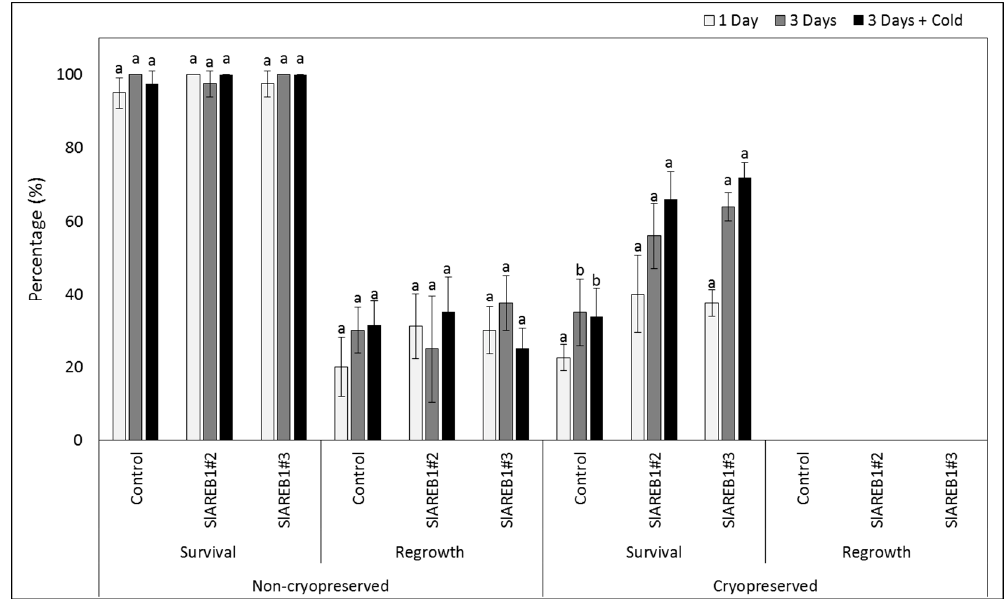
Figure 6. Survival and regrowth percentages of V-cryoplates treated non-cryopreserved and cryopreserved shoots tips of negative control, SlAREB1#2, SlAREB1#3 transgenic tomato plants as affected by pretreatment with 0.3 M sucrose concentration for one day or three days with or without cold acclimatization (values are the mean ± SD). Based on Tukey ′ s HSD test, different letter indicates significant difference among transgenic lines ( p < 0.05) for each combination of cryopreservation and cold acclimatization treatment.